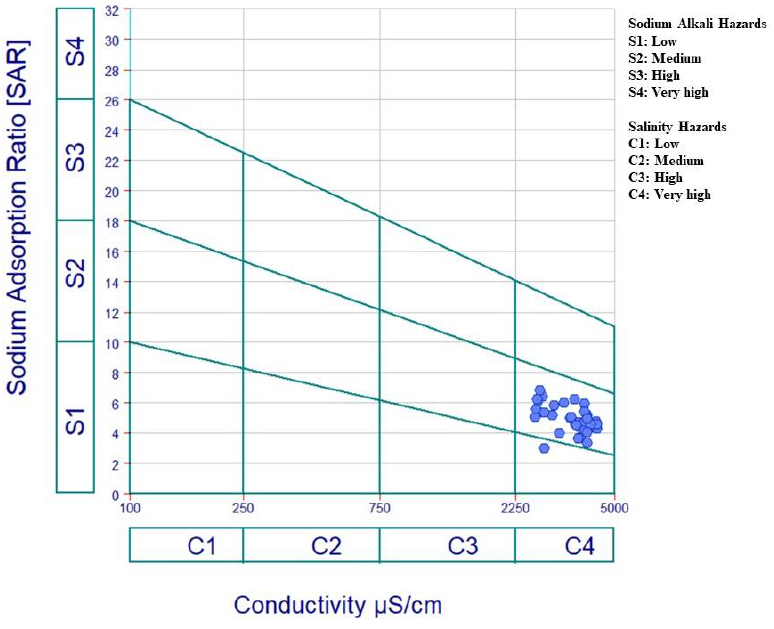
Figure 9. USSL diagram for irrigation purposes.